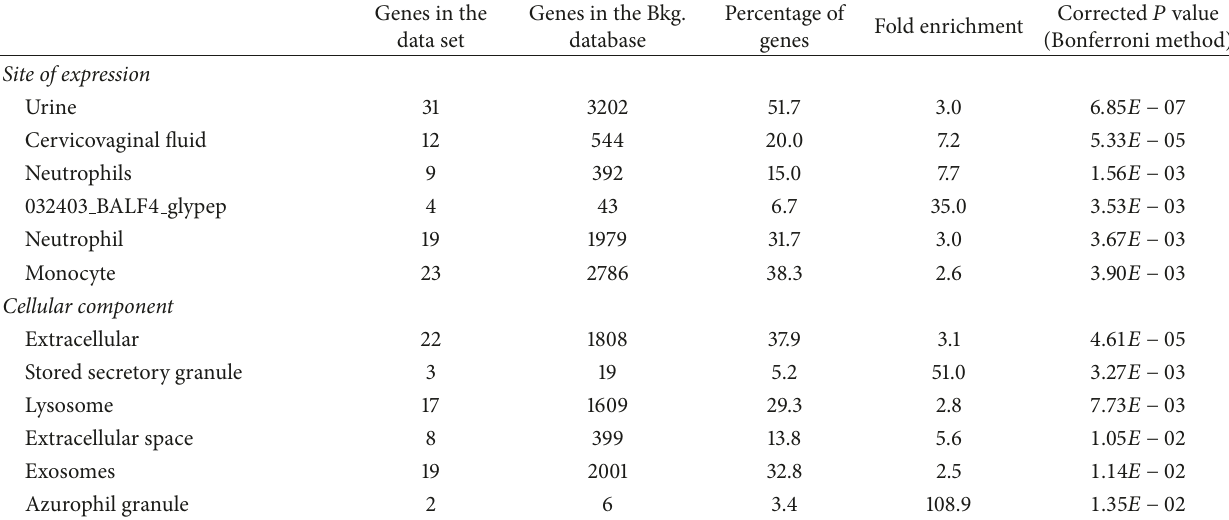
Table 10: Functional analysis of overlapping HIV+ and HIV − EV proteins. Genes in